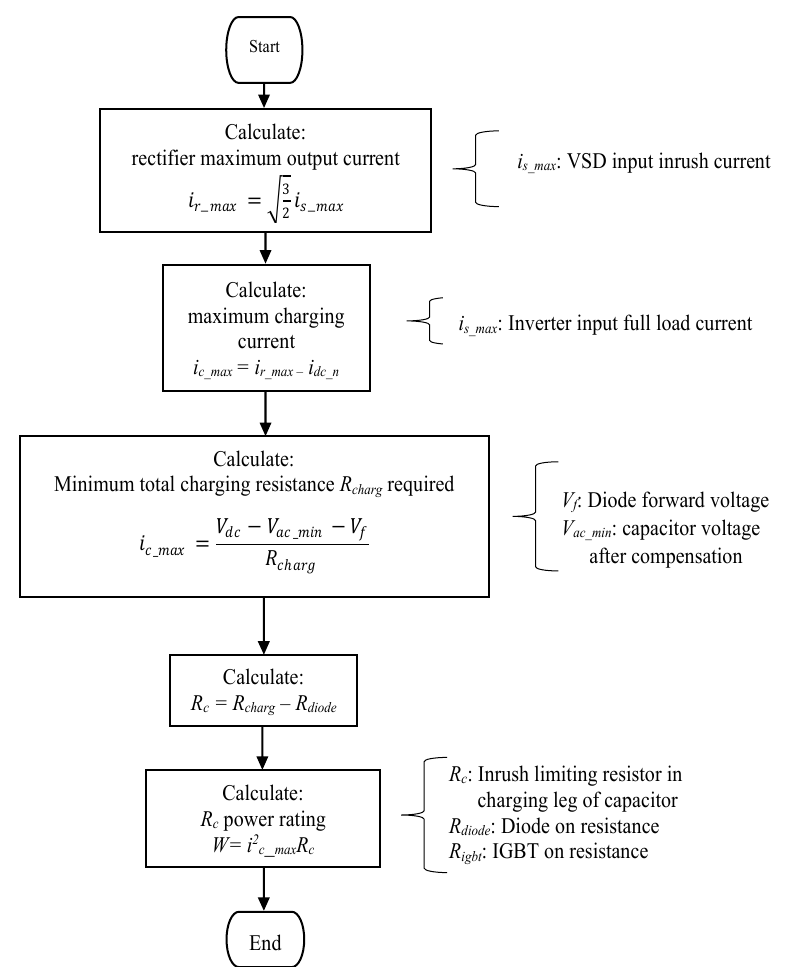
Figure 6. Charging inrush current limiting resistor sizing flowchart.